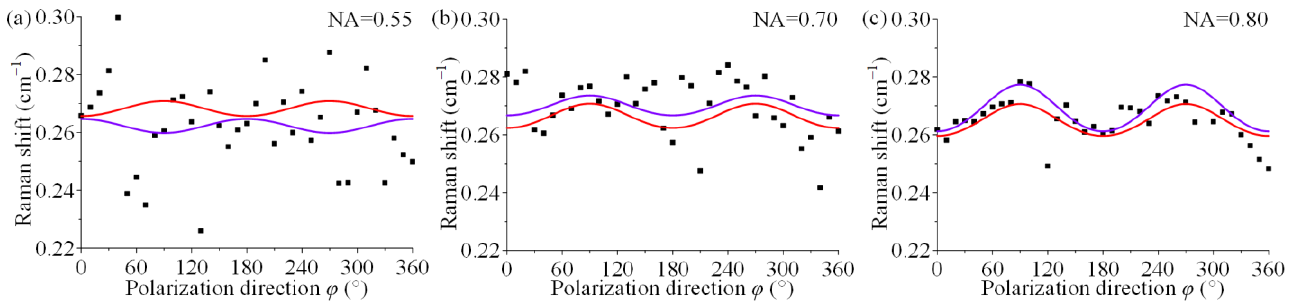
Figure 4. Experimental results of sample 1 with different NAs: ( a ) NA = 0.55, ( b ) NA = 0.70, ( c ) NA = 0.80, where black solid points are experimental data points, the red curve is the theoretical result, and the purple curve is the fitted result.